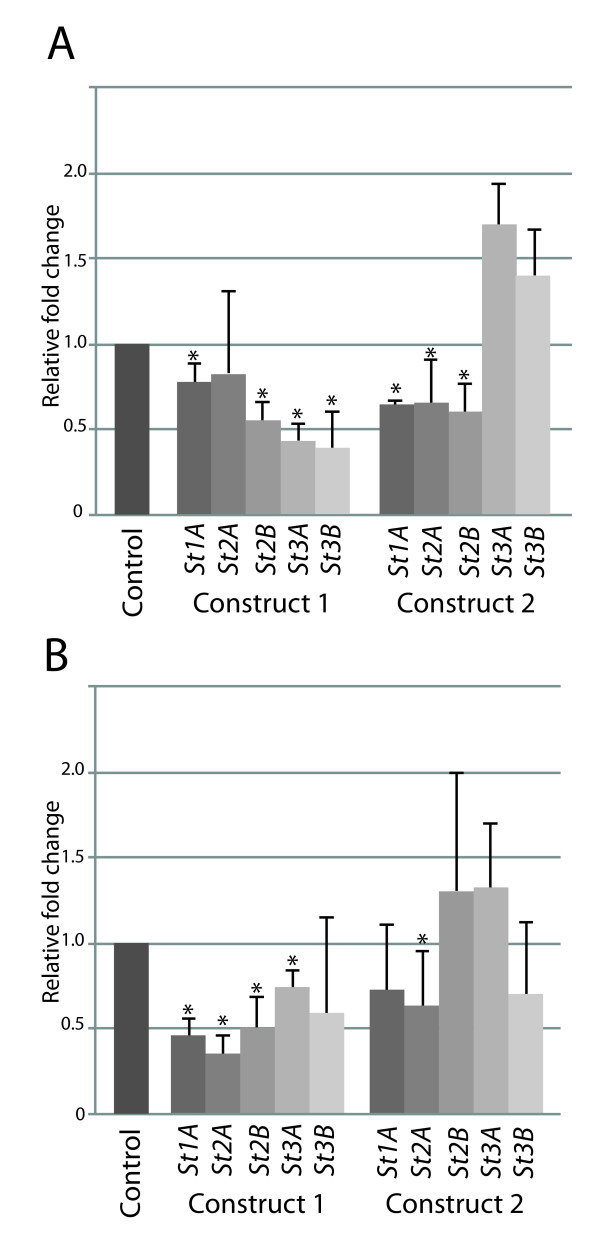
Relative qPCR values of St gene transcripts when inoculated with VIGS constructs 1 and 2 compared to empty vector control. Both GA06/18 (A) and Sila (B) genotypes showed down-regulation of five of the six St genes when inoculated with either one, or both of the constructs. Error bars indicate standard deviation between three biological replications. * Indicates a significant decrease (P < 0.05) compared to control levels.